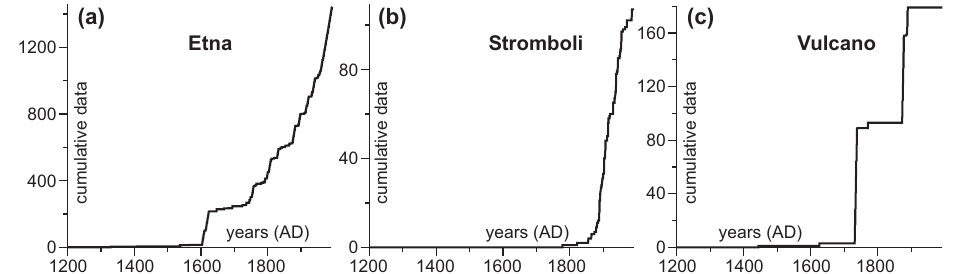
Fig. 3a-c. Relationships between the cumulative number of data ( i.e ., months including eruptions with VEI ≥ 2) and time for (a) Etna, (b) Stromboli, and (c) Vulcano. Data (table III) are from Simkin and Siebert (1994).